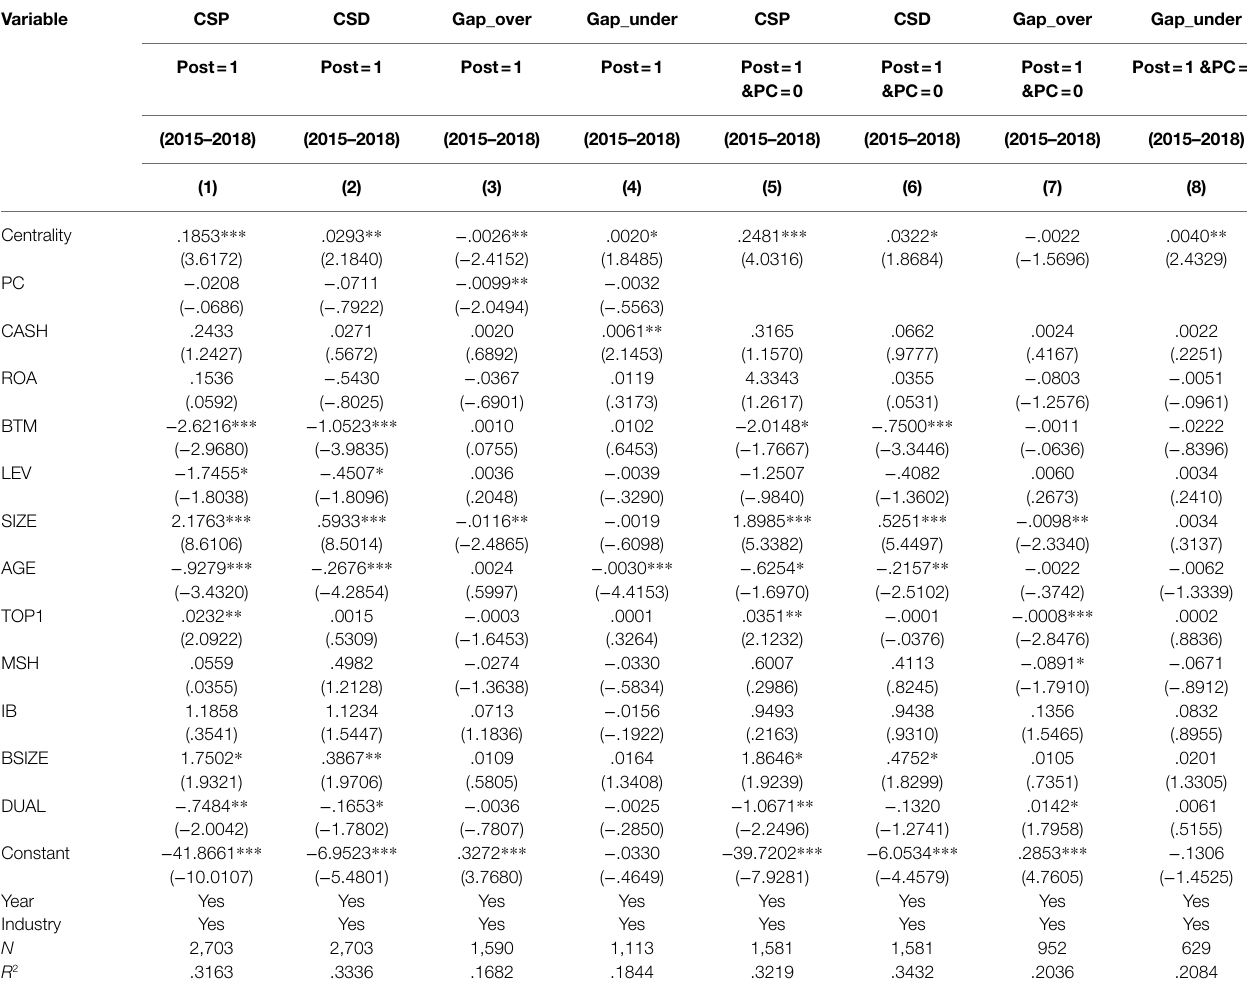
TABLE 7 | Alternative explanation of political